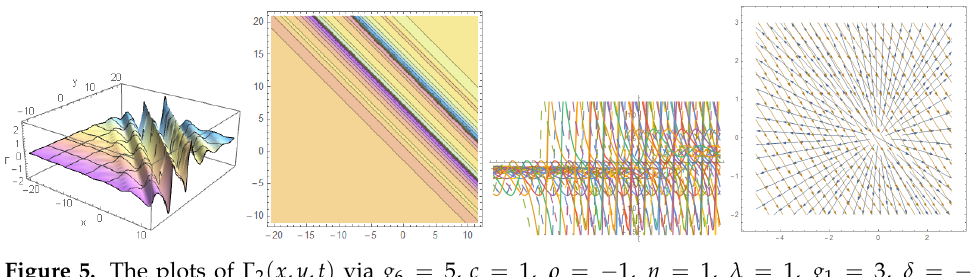
Figure 5. The plots of Γ 2 ( x , y , t ) via g 6 = 5, c = 1, ρ = − 1, η = 1, λ = 1, g 1 = 3, δ = − 2, g 4 = 3, z 1 = 1, and t = 5.